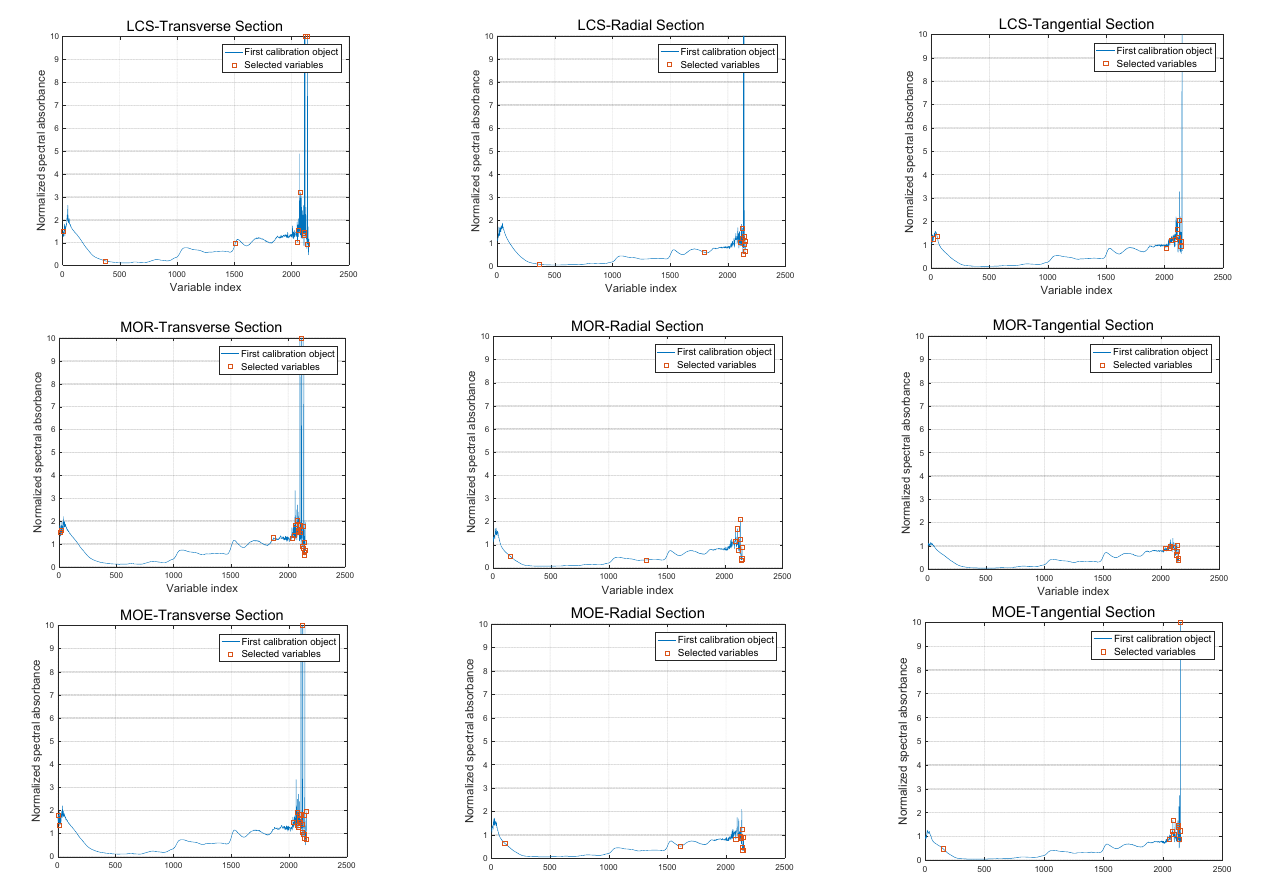
corresponding full ‐ band spectral model. SPA obtained 10 characteristic wavelengths; the R 2 of calibration set and validation set were 0.4787 and 0.7635, and RMSE were 9.2175 and 5.2613, respectively. The accuracy of the SPA ‐ PLS model in different sections of MOE was lower than the full ‐ band spectral model, and the radial section SPA ‐ PLS model was the best. SPA selects 10 characteristic wavelengths of radial section to construct PLSR model, with Rc 2 = 0.5598 and Rv 2 = 0.8394, RMSEc = 972.4311 and RMSEv = 575.7233.